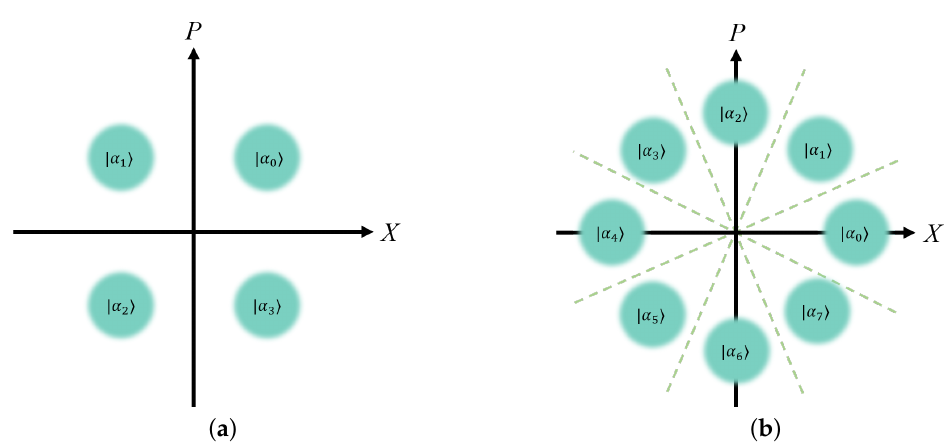
Figure 1. Phase space representations of coherent states with ( a ) four-state modulation and ( b ) eight-state modulation.